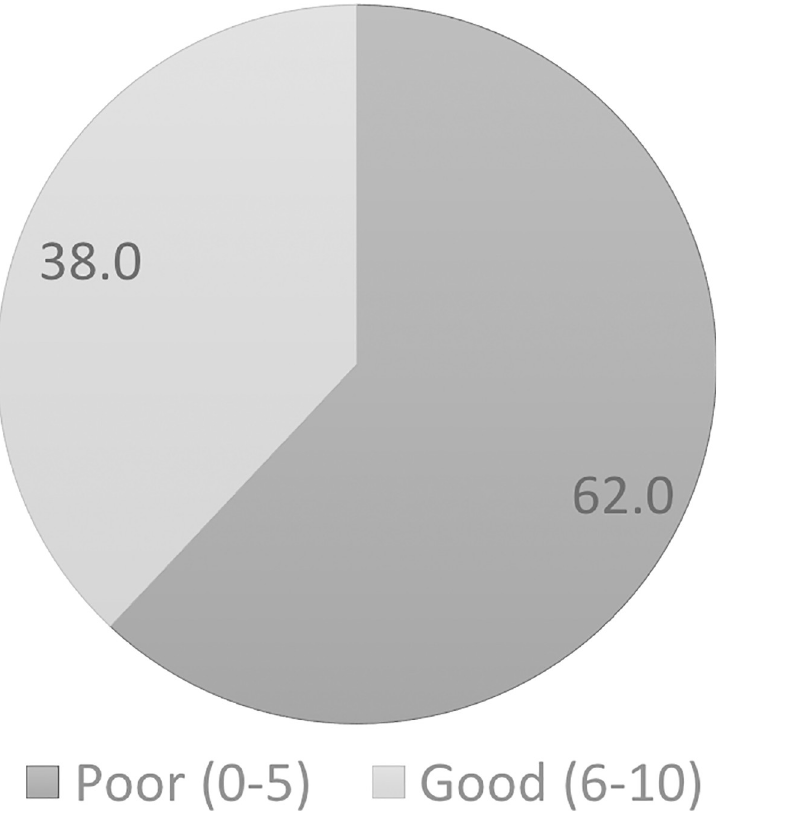
Fig 1. Knowledge regarding COVID-19 vaccine category (N =